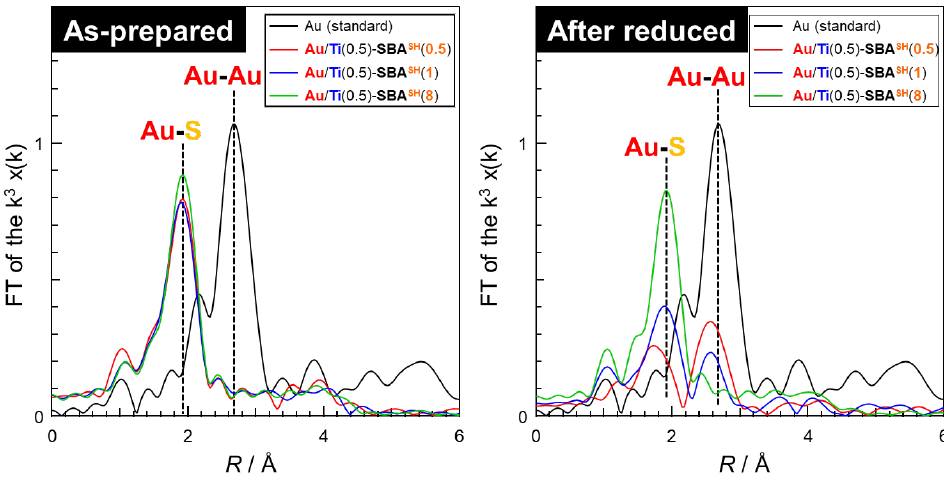
Figure 4. XAFS of Au/Ti(0.5)-SBA SH ( y ) with y = 0, 0.5, 1, and 8. The immobilized amount of Au also depended on the amount of alkylthiol on the sup- ports. For the non-thiol-functionalized support ( y = 0), a few Au species were immobilized on the solid filtered, and washed from the suspension of Ti(0.5)-SBA SH (0) and NaAuCl 4 in EtOH. For Au/Ti(0.5)-SBA SH ( y ) with 0 < y ≤ 4, the amount of the immobilized Au increased as increasing the alkylthiol content but was almost the same for the supports with y = 4 and y = 8 (Figure 6 and Table 2), respectively. On the titanium loadings varied catalysts Au/Ti( x )-SBA SH (0.5) with 0 < x ≤ 2, the loading amount of Au was almost constant as shown in Table 2. The color of these catalysts was the same. Therefore, the loadings of titanium(IV) did not affect the immobilized amount and size of the Au